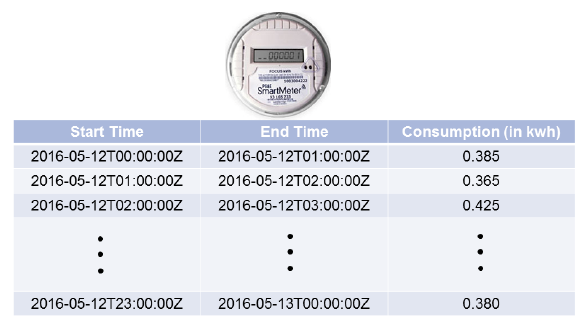
Figure 5. Hourly energy consumption values from a smart